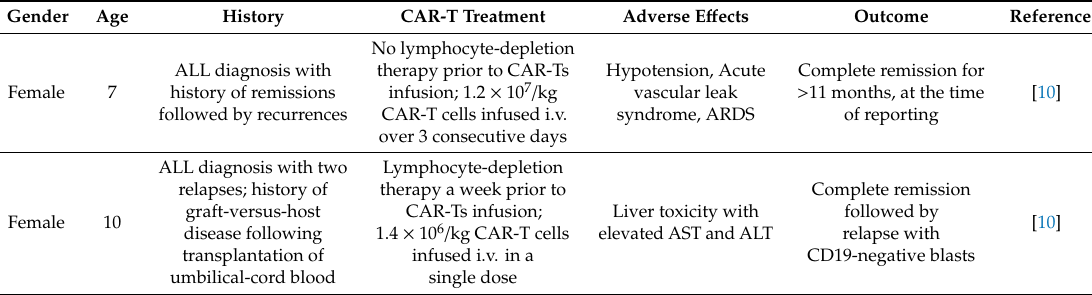
Table 3. Clinical study of CAR-Ts in pediatric Acute Lymphoblastic Leukemia